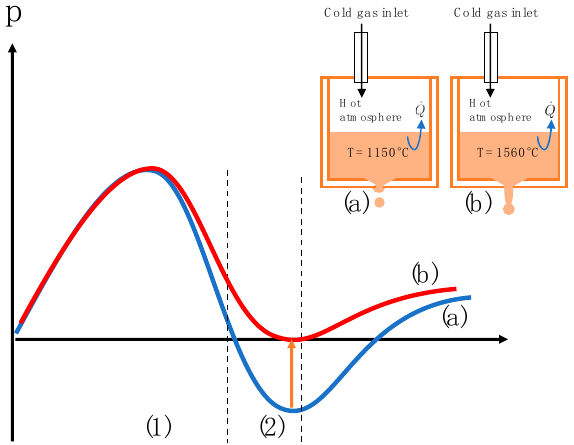
Figure 13. The pressure curve difference for medium melting metals (1150 °C), as in (a), and high melting metals (1560 °C), as in (b), as a result of gas expansion; interval (1) refers to the ejection phase of the droplet and interval (2) illustrates the separation phase.